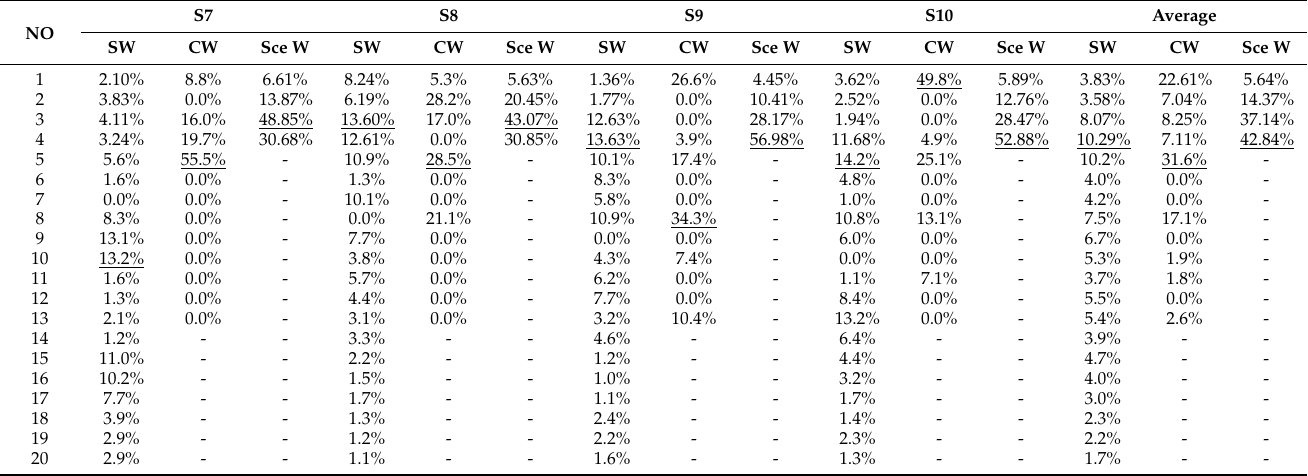
Table A3. Results of pairwise comparison of the Saaty scale (from − 9 to 9) for the Wonosobo group.